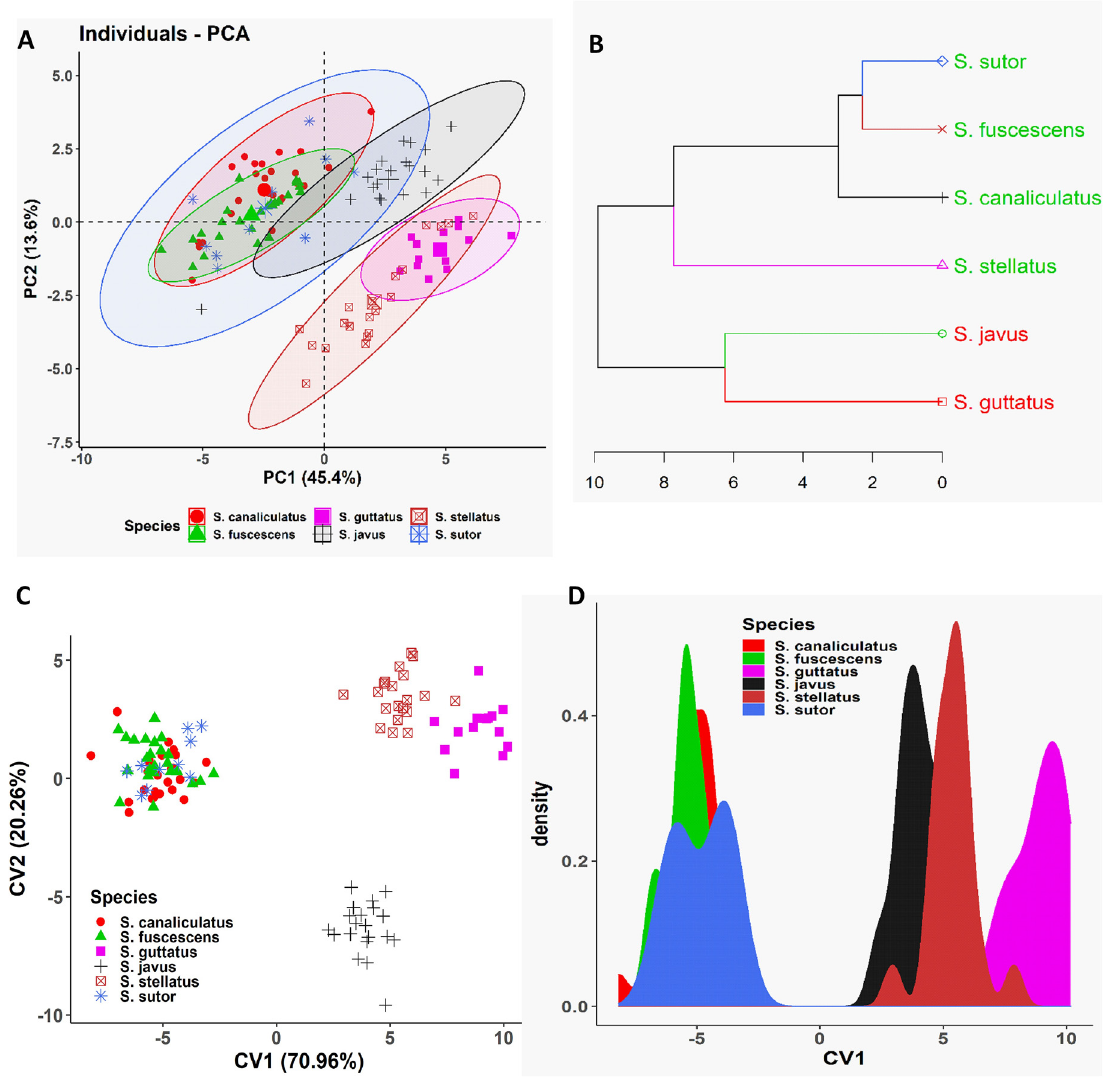
Figure 2. Multivariate analyses of morphometric data of different siganid species collected from the South China Sea, Terengganu, Malaysia. ( A ) Biplot of principal component analysis is shown based on the morphometric data of different siganid species. ( B ) Dendrogram derived from cluster analyses of morphometric measurements is shown based on Euclidean distance of different siganid species. ( C ) Biplot of canonical variates analysis (CVA) is shown based on the morphometric data of different siganid species. ( D ) Coordinate density plot of canonical variate 1 is shown based on the morphometric data of different siganid species.